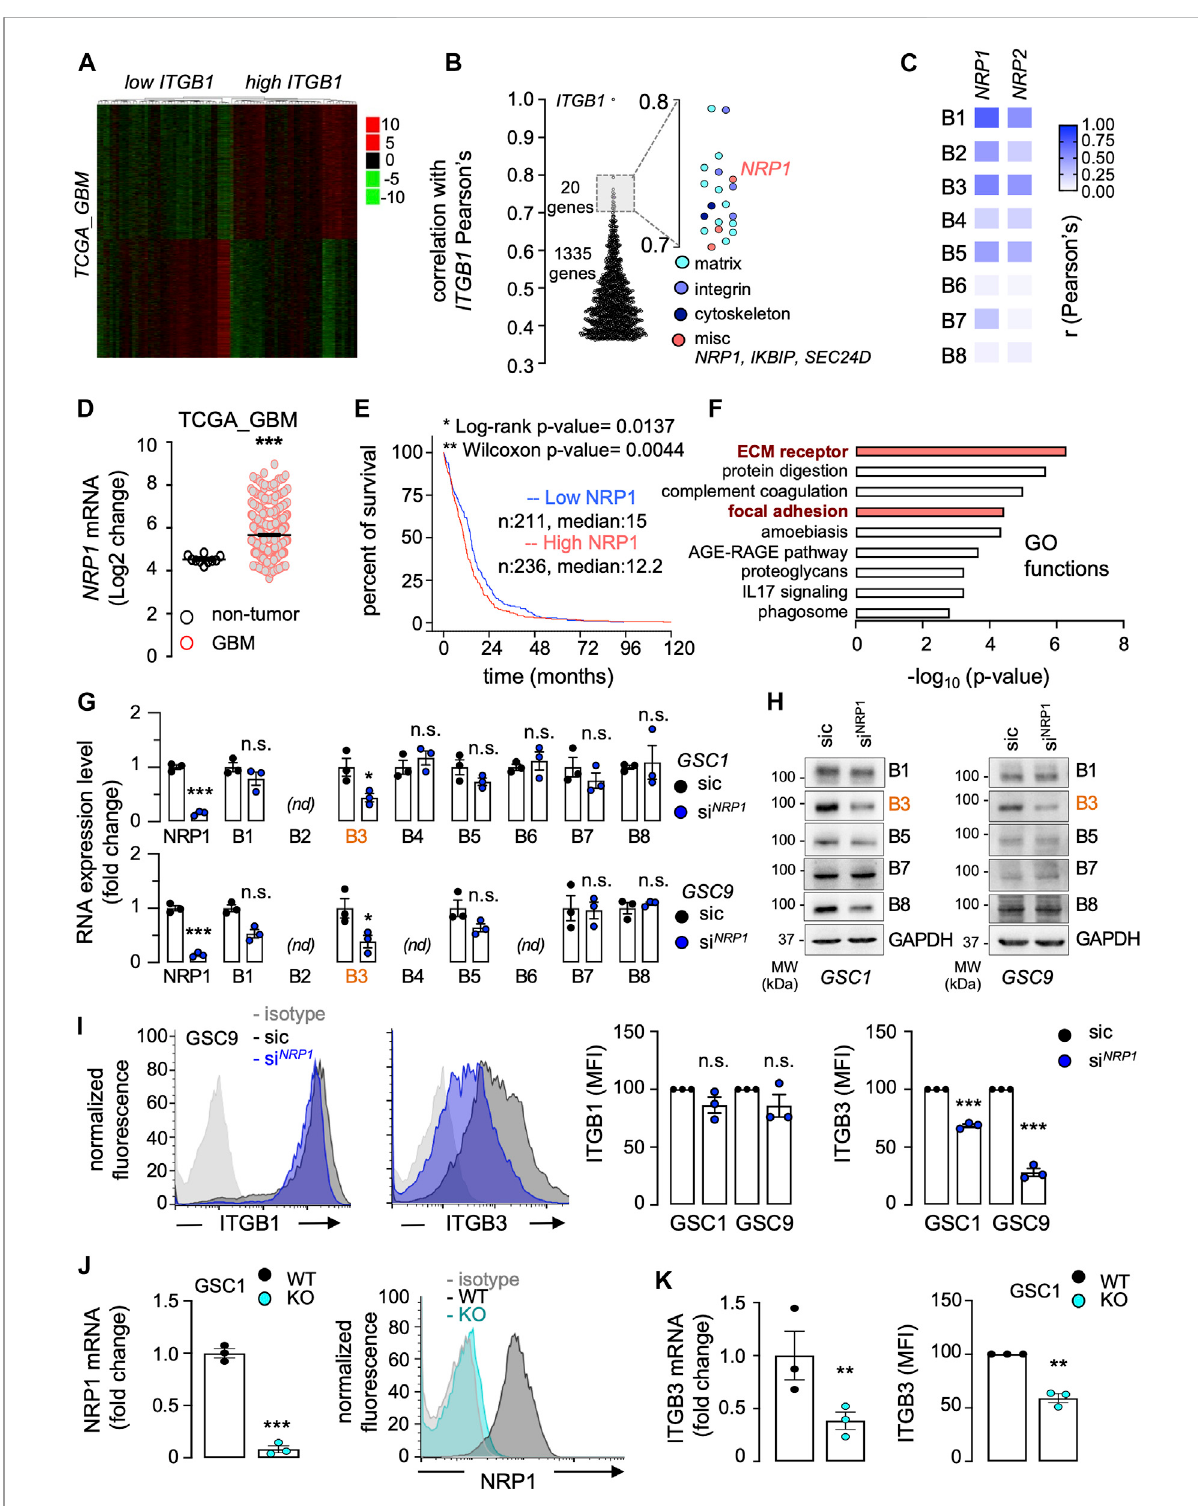
FIGURE 2 Neuropilin-1 expression emerges as a co-dependent factor of integrins in GBM. (A – F) The Cancer Genome Atlas (TCGA RNAseq dataset) was interrogated via theGlioVisplatformto analyze differential geneexpression in528GBMpatients. Patients wereclusteredbetween loworhigh ITGB1 mRNA expression (median cut-off). Representation of heatmap (A) and Pearson ’ s correlation factors (B) between each differentially expressed gene and ITGB1 ,withafocusontheoneswithapositivecorrelationrangingfrom0.7to0.8.Pearson ’